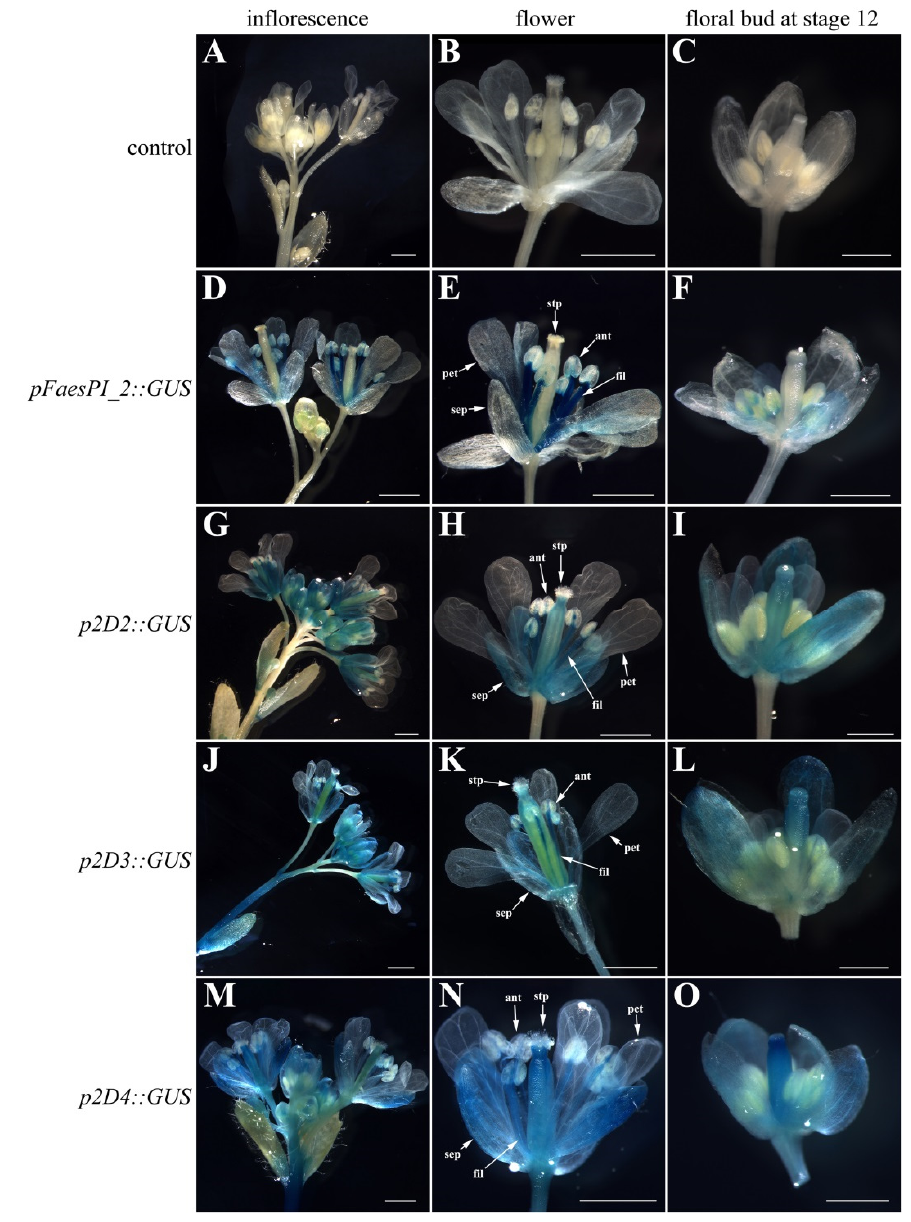
Figure 7. Histochemical GUS staining in the T1 generation of pFaesPI_2 :: GUS transgenic Arabidopsis and deletion analysis of the pFaesPI_2 promoter. ( A ) wild-type Arabidopsis Inflorescence; ( B ) wild-type Arabidopsis flower; ( C ) stage 12 floral bud of Wild-type Arabidopsis ; ( D ) inflorescence of pFaesPI_2 :: GUS transgenic Arabidopsis; ( E ) mature flower of pFaesPI_2 :: GUS transgenic Arabidopsis; ( F ) stage 12 floral bud of pFaesPI_2 :: GUS transgenic Arabidopsis; ( G ) inflorescence of p2D2 :: GUS transgenic Arabidopsis; ( H ) mature flower of p2D2 :: GUS transgenic Arabidopsis; ( I ) stage 12 floral bud of p2D2 :: GUS transgenic Arabidopsis; ( J ) inflorescence of p2D3 :: GUS transgenic Arabidopsis; ( K ) mature flower of p2D3 :: GUS transgenic Arabidopsis; ( L ) stage 12 floral bud of p2D3 :: GUS transgenic Arabidopsis; ( M ) inflorescence of p2D4 :: GUS transgenic Arabidopsis; ( N ) mature flower of p2D4 :: GUS transgenic Arabidopsis; ( O ) stage 12 floral bud of p2D4 :: GUS transgenic Arabidopsis . sepal (sep), petal (pet), anther (ant), filament (fil), stigmatic papillae (stp); Scale Bars: ( A , B , D , E , G , H , J , K , M , N ) 1 mm; ( C , F , I , L , O ) 500 μ m.